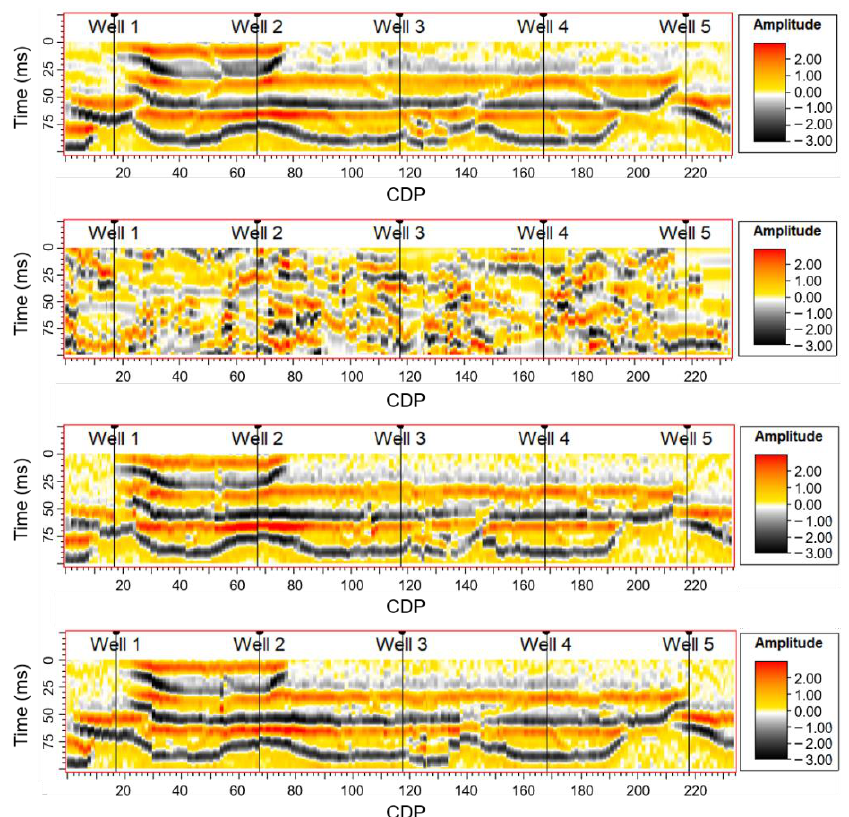
Figure 6. Seismic records obtained through well inversion (from top to bottom , real reservoir, TPI, MPI, and LPUMI).